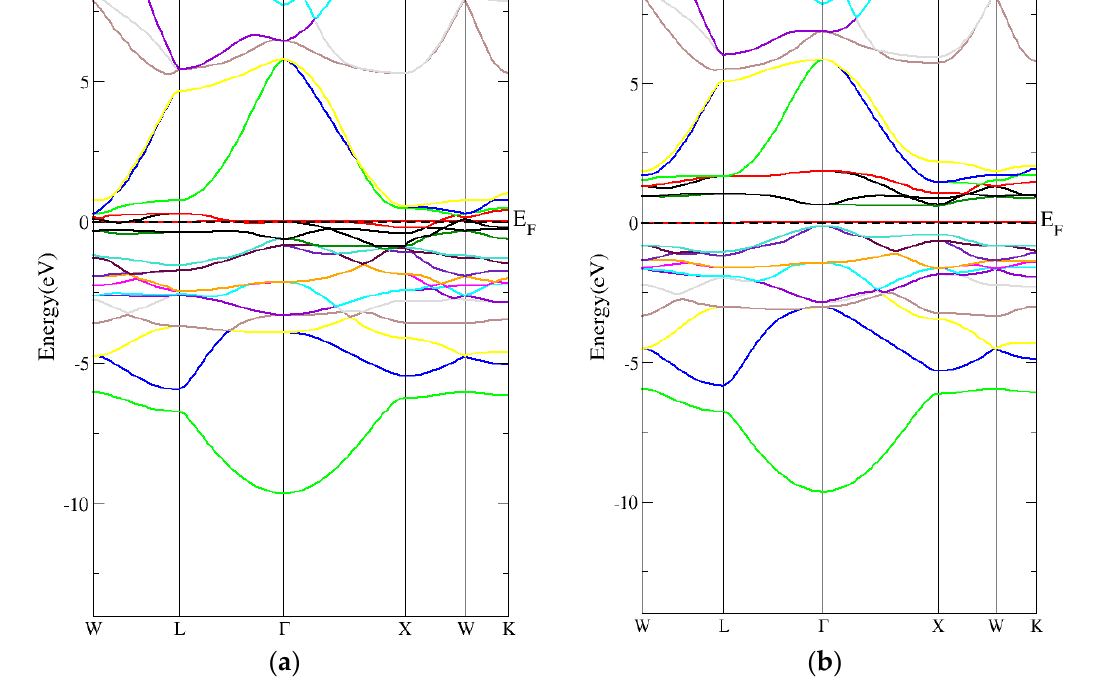
Figure 6. The band structure for the conventional Heusler Co 2 CrAl compound by employing the PBE-GGA technique for ( a ) spin-up conventional Heusler Co 2 CrAl compound and ( b ) spin-down conventional Heusler Co 2 CrAl compound.